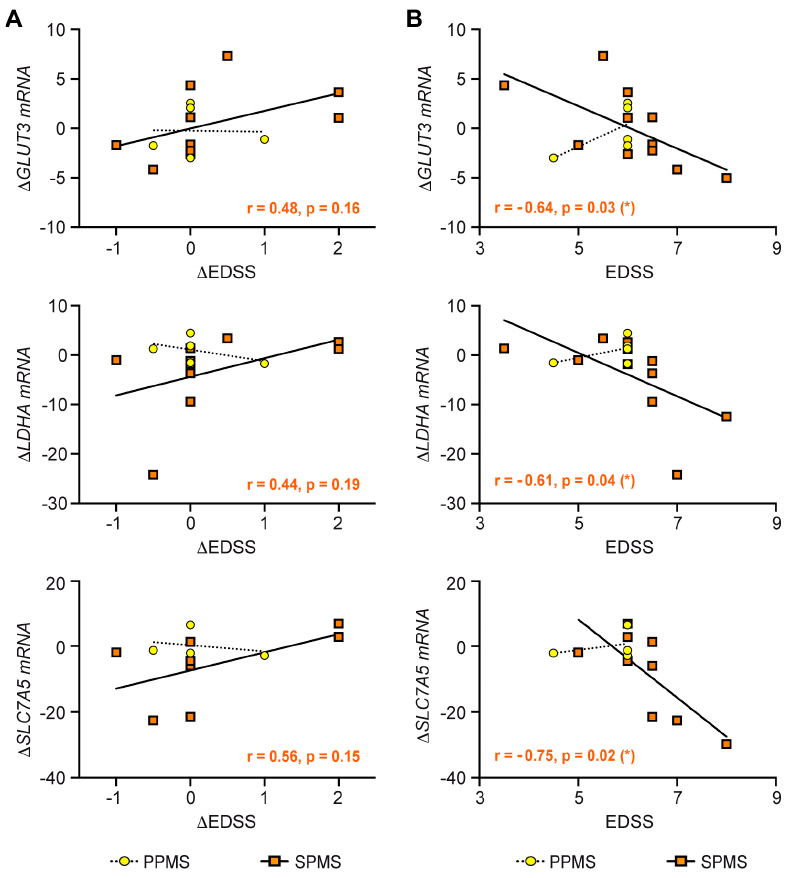
Figure 8. Correlation between changes in metabolic gene expression in human peripheral blood T cells from PPMS and SPMS patients during IVMP therapy and clinical parameters. ( A ) For each patient the ∆ EDSS score was determined as the difference between the EDSS at the time of blood collection and the EDSS at initial diagnosis with a negative ∆ EDSS indicating clinical improvement. The ∆ gene mRNA value reflects the fold difference between gene expression before and after IVMP with a negative value indicating a decrease in gene expression after therapy. The graphs depict the correlation between both parameters separately for PPMS and SPMS patients with each dot representing one individual patient. The solid line represents the linear regression curve for SPMS, the dotted line for PPMS patients. N = 4–5 (PPMS), N = 8–10 (SPMS). ( B ) The graphs depict the correlation between the EDSS score at the time of blood collection and the ∆ gene mRNA value separately for PPMS and SPMS patients with each dot representing one individual patient. The solid line represents the linear regression curve for SPMS, the dotted line for PPMS patients. N = 4–5 (PPMS), N = 9–11 (SPMS). The Spearman correlation coefficient (r) and the level of significance (* p < 0.05) are indicated in each graph solely for the analysis of SPMS patients.